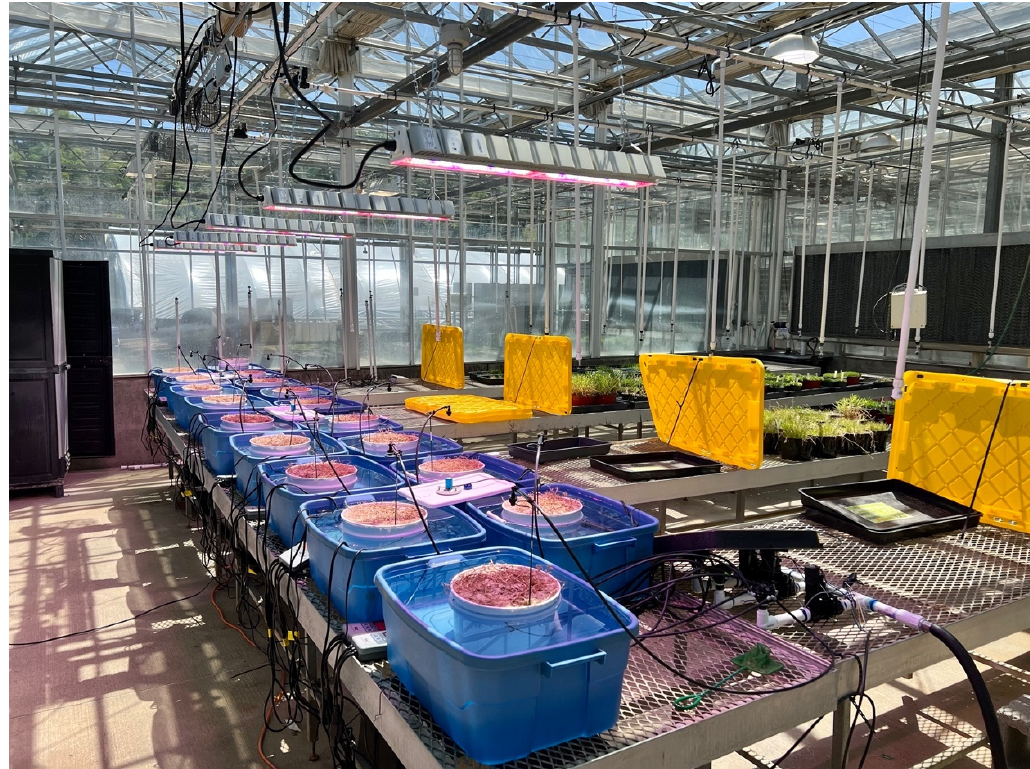
Figure 1. Experimental area utilized to evaluate ‘Prizm’ zoysiagrass ( Zoysia matrella (L.) Merr.) establishment from sprigs during 2022 in Knoxville, TN.